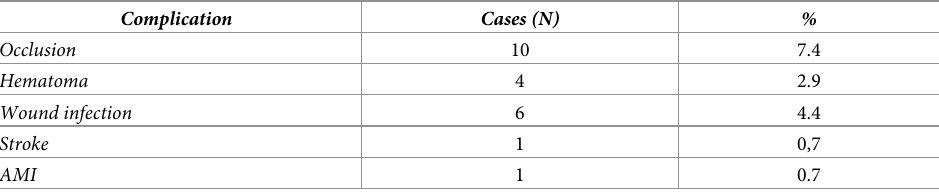
Table 2. Early postoperative complications.